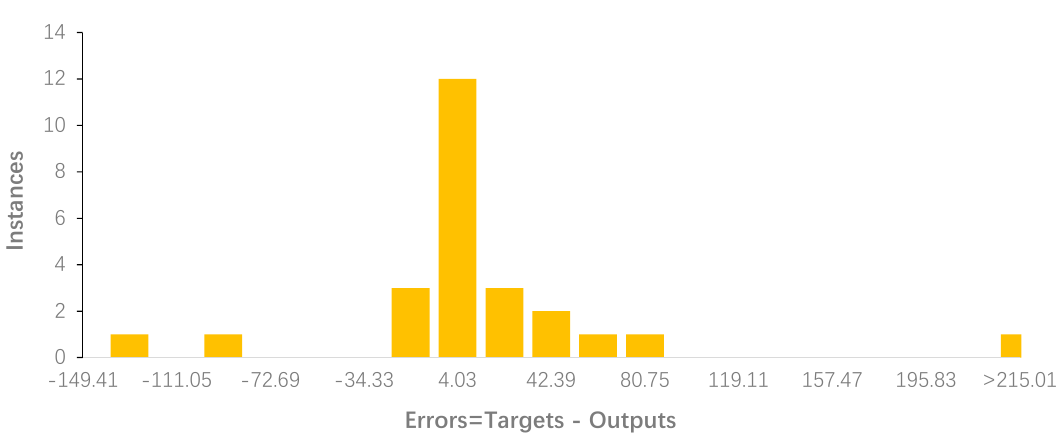
Figure 6. Error distribution during the development and testing of the ANN model for N 2 O emissions.